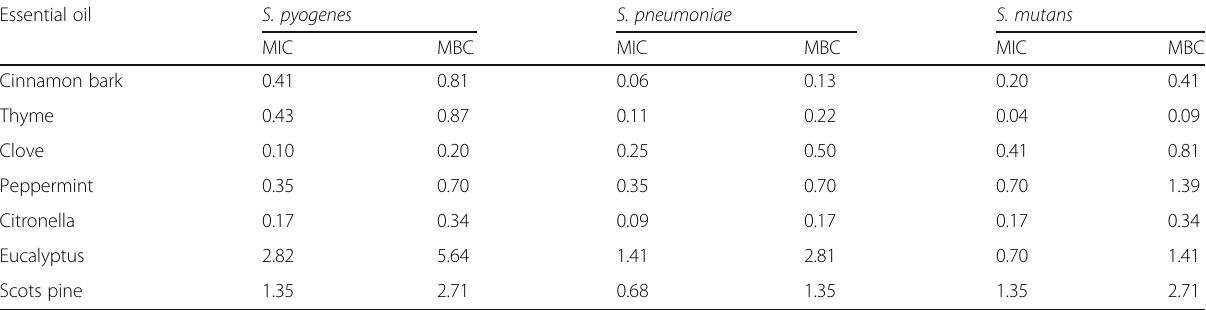
Table 2 Antibacterial activity of EOs against Streptococcus spp. by broth macrodilution Essential